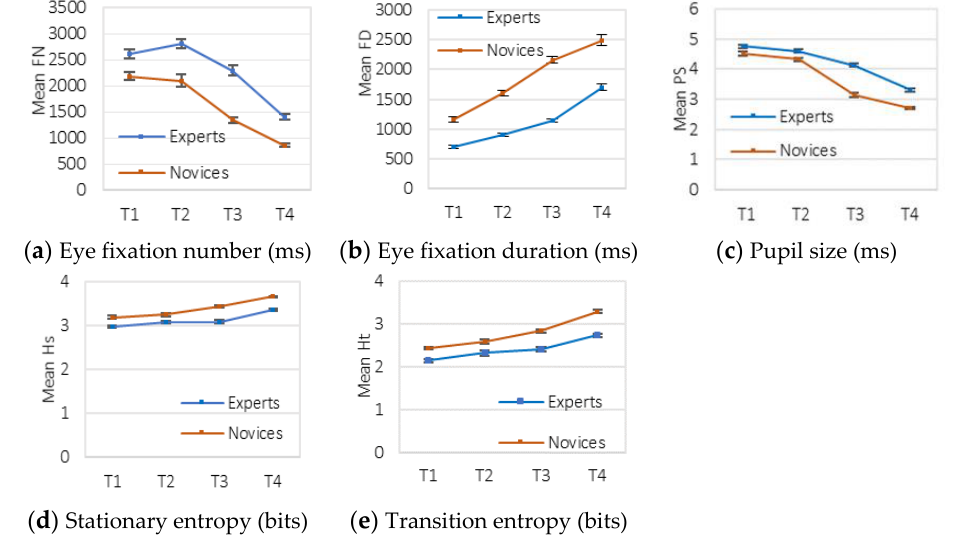
Figure 6. Means and standard errors of the eye movement measures.